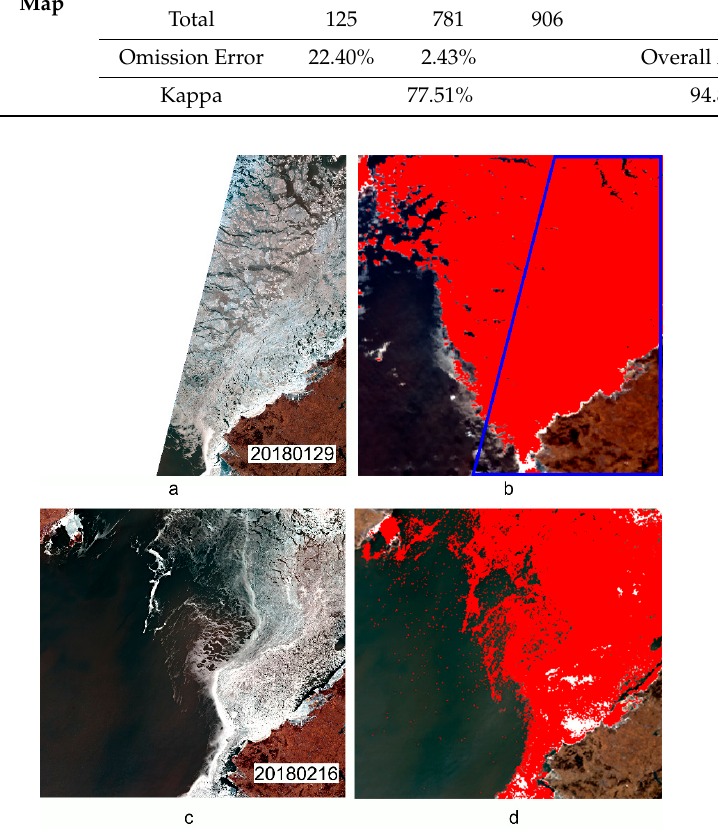
Figure 7. Sea ice extraction results based on ENDSIII OLCI from OLCI images with 300 m spatial resolution on 29 January 2018 ( b ) and February 16, 2018 ( d ). Two true-color images in the first column ( a , c ) are the MSI validation images with 60 m spatial resolution. The blue box in ( b ) represents the boundary of the validation image ( a ).